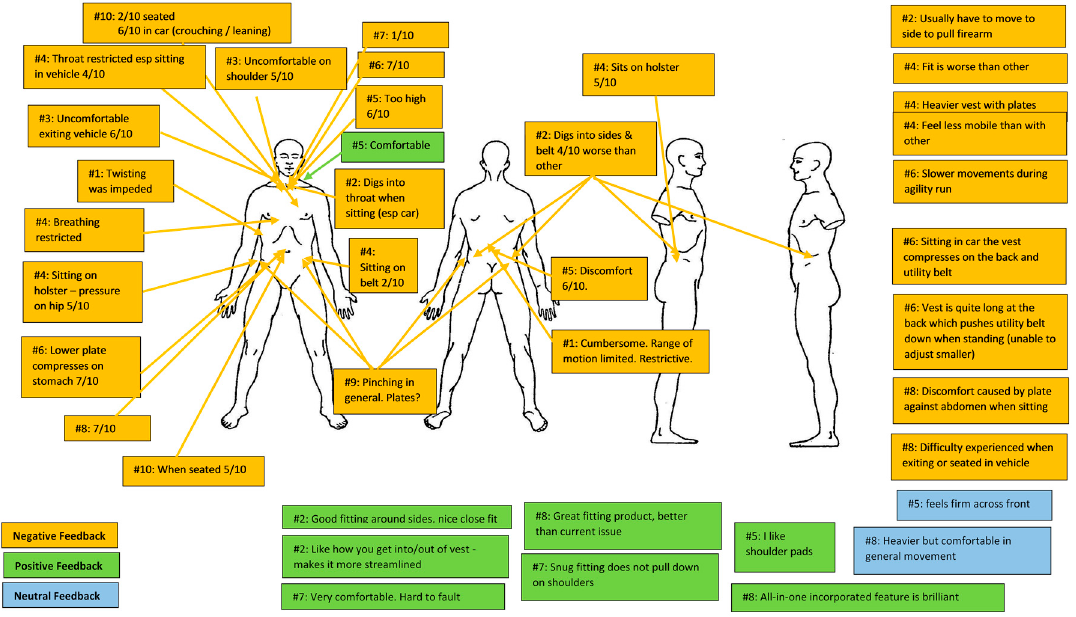
Figure 3. Subjective feedback on military body armour (# signifies participant number; scores out of 10 signify discomfort level).